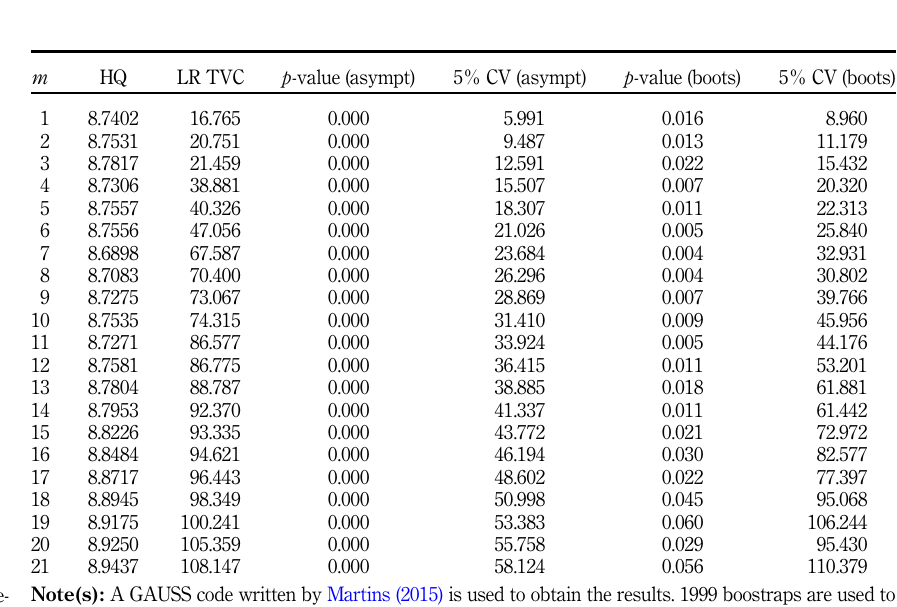
Table 6. The Swensen ’ s i.i.d. bootstrap test of time- varying cointegration